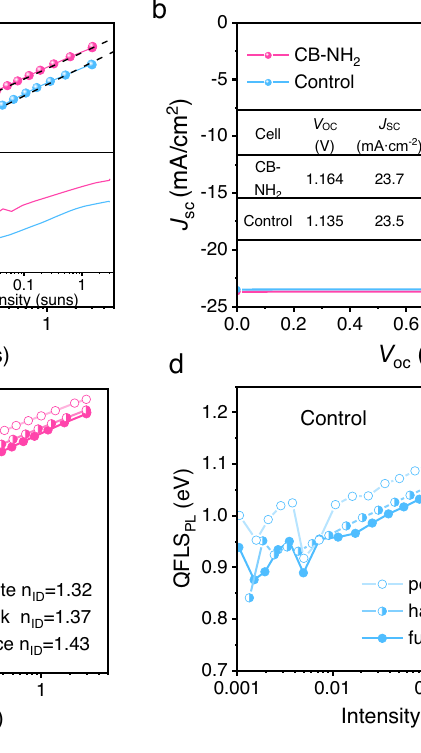
d control sample, respectively. The n ID is smaller for samples with carborane, indicating less non-radiative recombination. Source data are provided as a Source Data fi le.